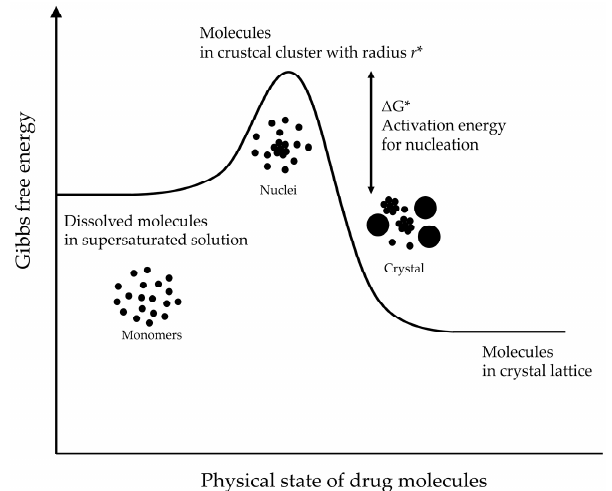
Figure 2. Schematic representation of the Gibbs free energy of molecules presented in a supersaturated solution. Adapted from Brouwers et al. [34] with permission (Elsevier 2009).